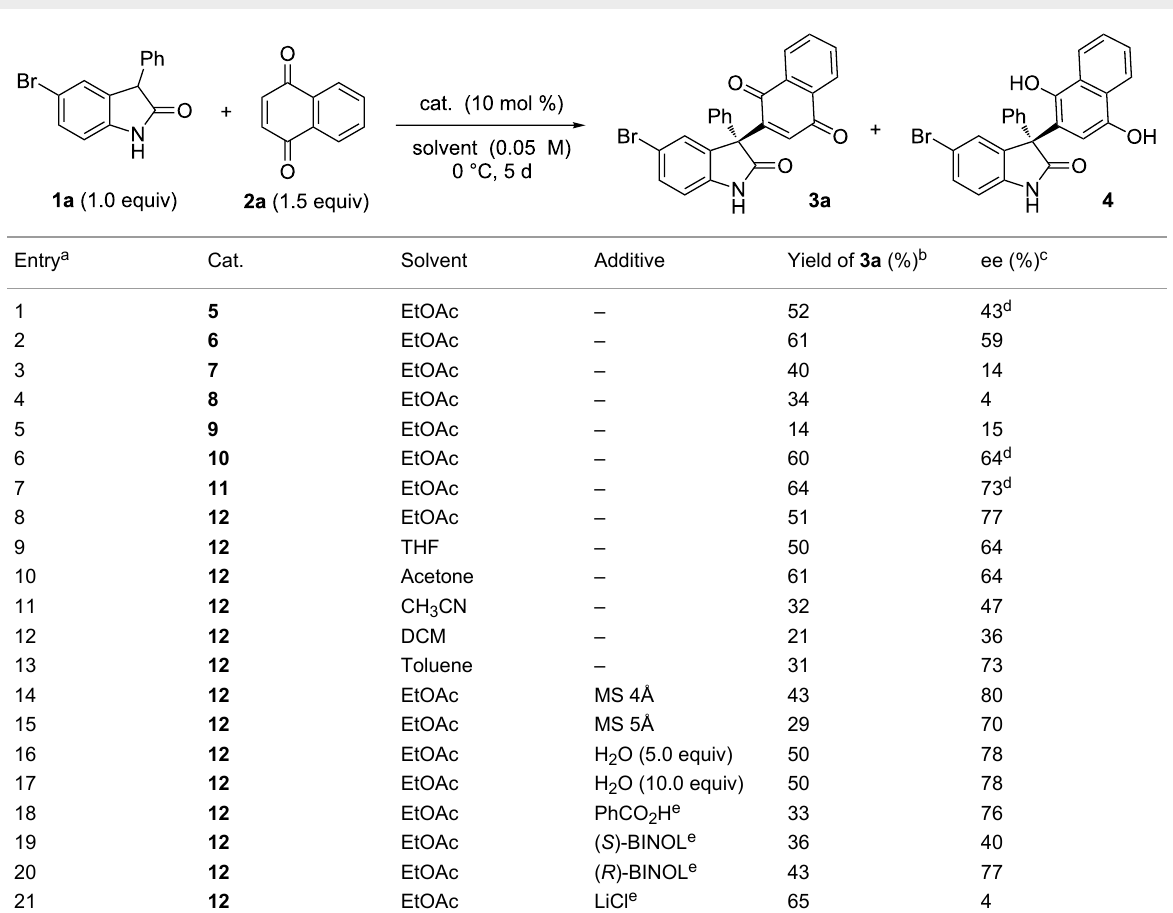
Table 1: Condition optimization for the reaction of 1a and 2a